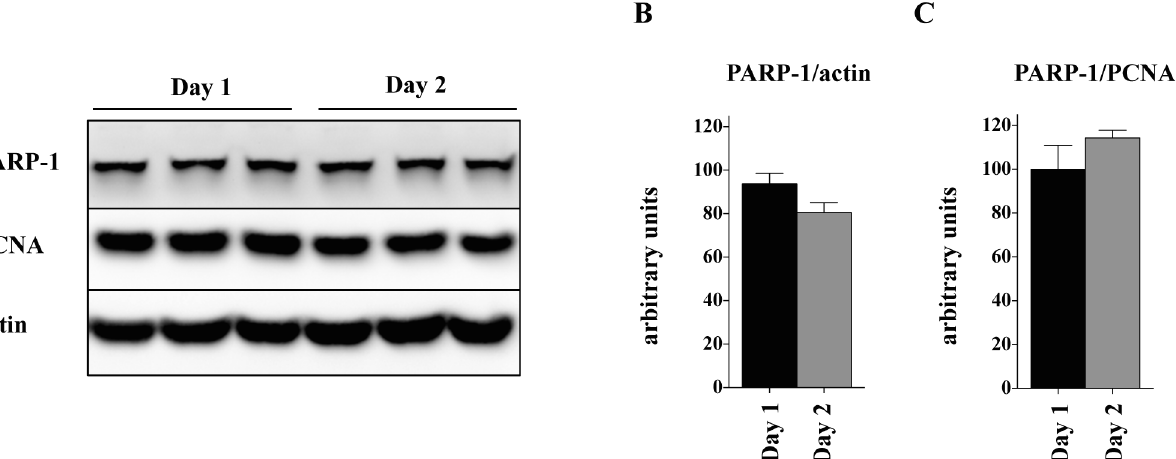
Fig 3. Lack of the contact inhibitory effect on PARP-1 expression in myoblasts. (A) Western blot analysis of PARP-1 in myoblasts at day 1 and 2 after reaching 100% confluence. Actin was used as a loading control. PARP-1 densitometric analysis was normalized to actin (B) or PCNA (C) ; values obtained in Day 1 cells were set as 100%. The results show no significant difference in PARP-1 protein between cells kept for 1 or 2 days after reaching 100% confluence.